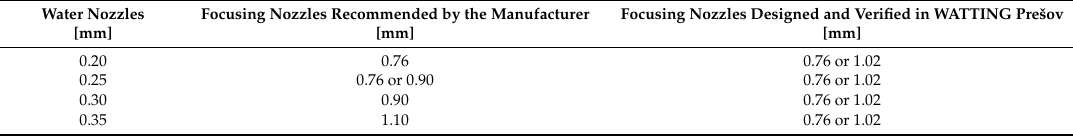
Table 12. Standard and proposed nozzle (jet) configurations.